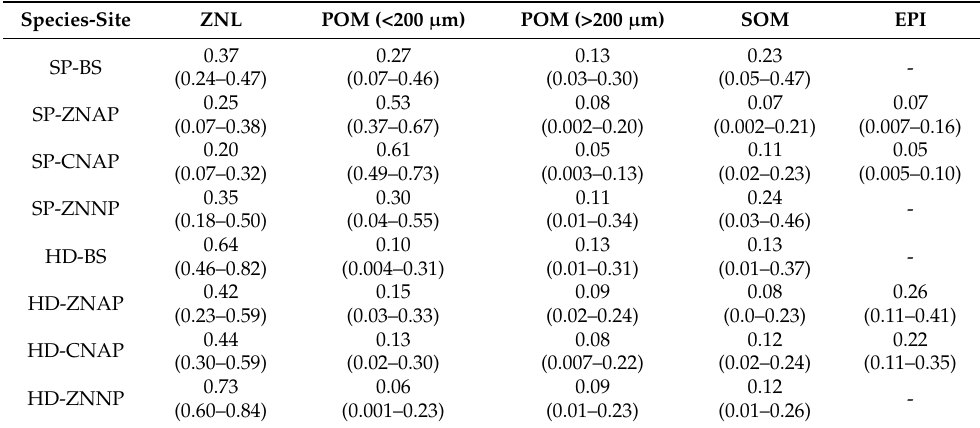
Table 3. Feasible contribution of the different food sources to the diet of Scrobicularia plana and Hediste diversicolor using the MixSIAR model in the different treatments. Five food sources were used: SOM, POM (<200 µ m), POM (>200 µ m), epiphytes (EPI), and Zostera noltei leaves (ZNL). SP, S. plana ; HD, H. diversicolor ; BS, bare sediment; ZNAP, artificial patches of Zostera noltei ; CNAP, artificial patches of Cymodocea nodosa ; and ZNNP, natural patches of Z. noltei . Values are presented as mean with their credible intervals at 5% and 97.5% (between